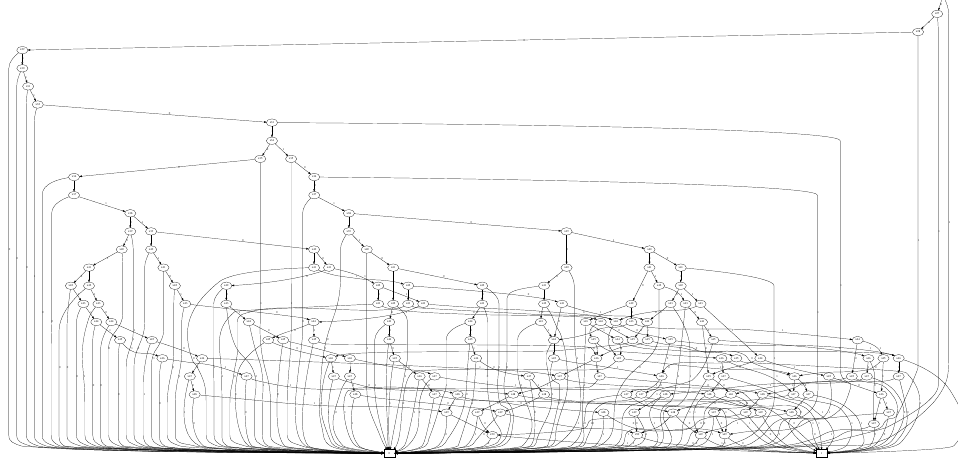
Figure 5. BDD for a set of 701 Geohashes. (Interconnection between the 25th–50th nodes is shown for brevity.)